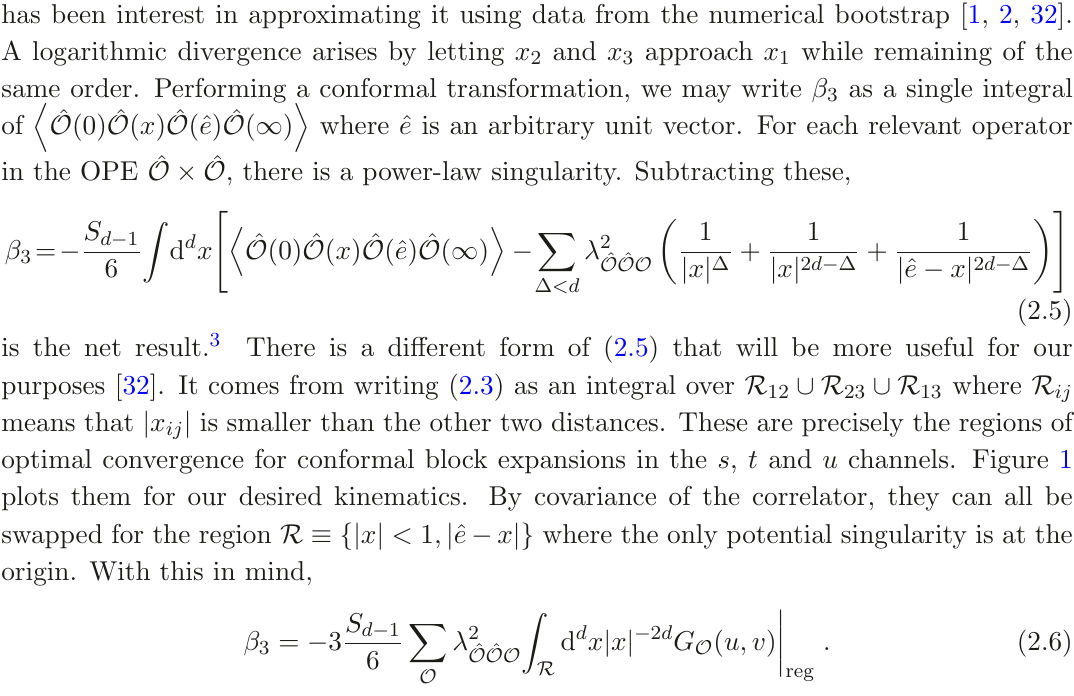
), 12 , 23 and 13 map to the blue, red ∞ R R R R